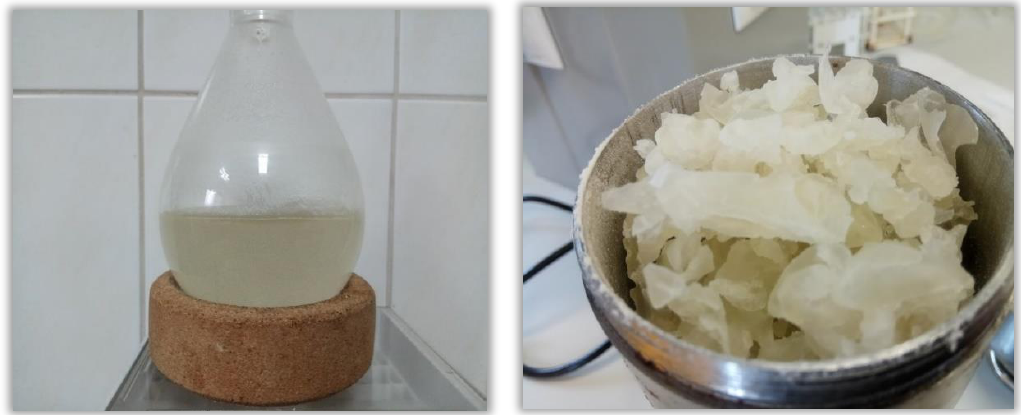
Figure 3. Starch gelatinized in 1-butyl-3-methylimidazolium chloride (wet and pre-dried form; Jan Dlugosz University, Czestochowa 2020).